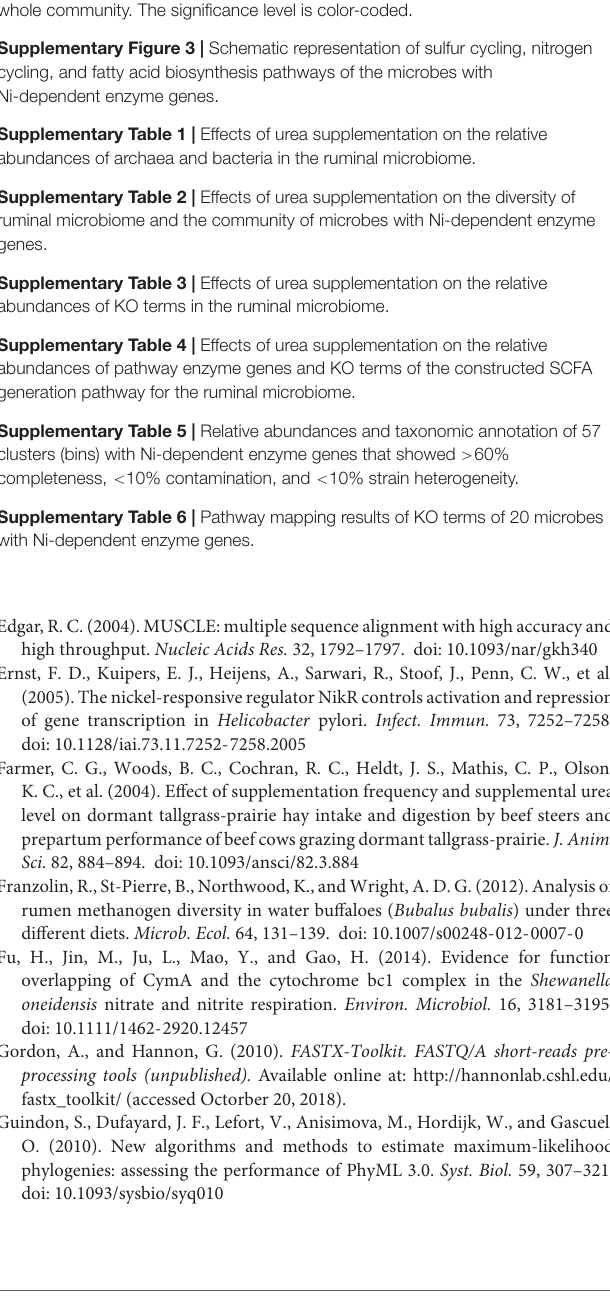
Supplementary Figure 1 | Non-metric multidimensional scaling (NMDS) plot visualizing the effects of urea supplementation on the compositions of (A) the